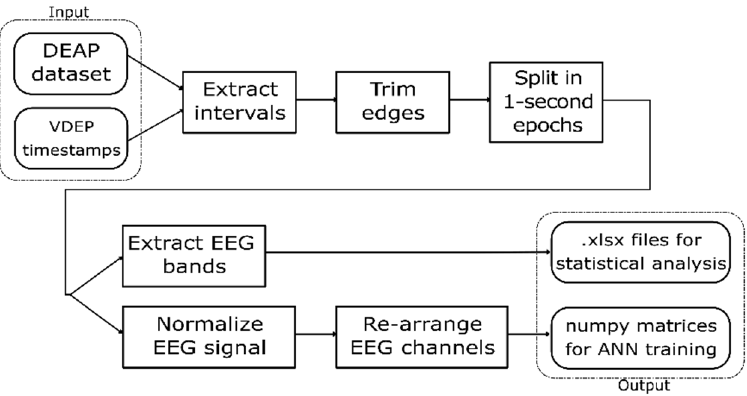
Figure 1. VDEP extraction-transformation process (ETP) from the DEAP dataset.